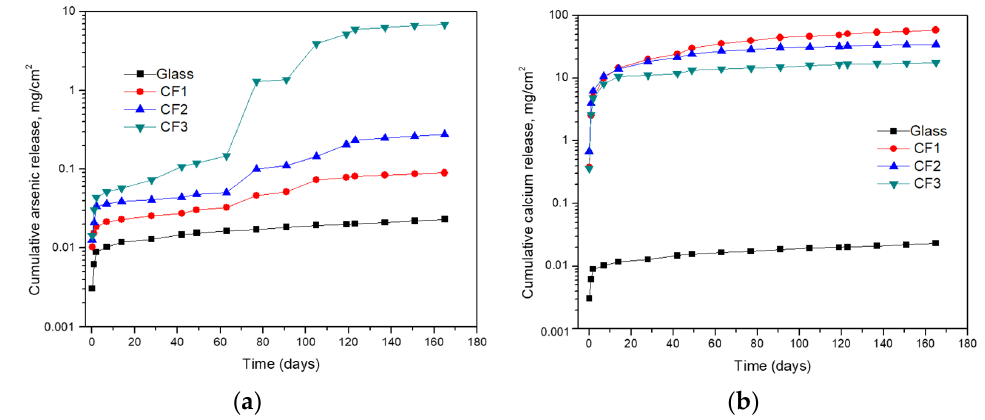
Figure 5. ( a ) Arsenic and ( b ) calcium release from cement-encapsulated and glass materials in method 1315.